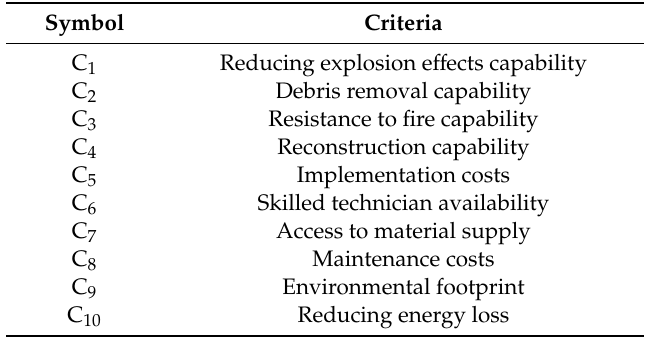
Table 2. Assessment indices of façade materials in blast-resistant buildings.